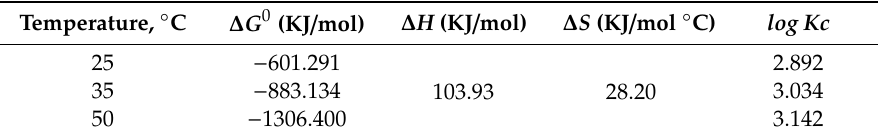
Table 4. Thermodynamics for As(V) adsorption on La 2 O 3 (0.1 g/L) at pH 6.0.